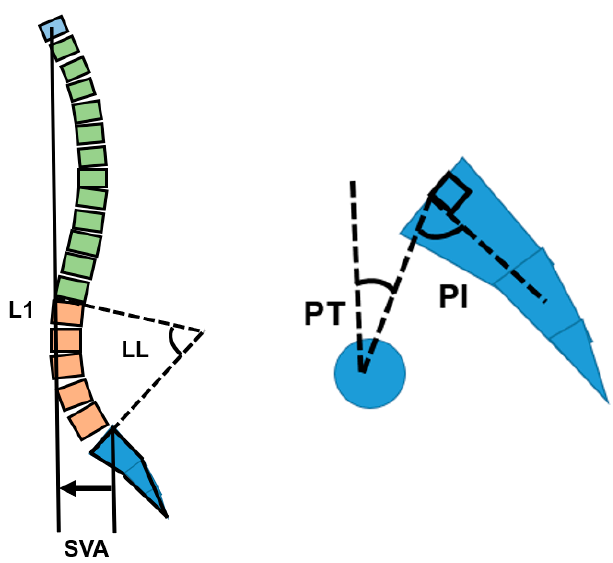
Figure 3. Spinopelvic parameter, SVA; sagittal vertical axis, LL; lumbar lordosis, PT; pelvic tilt, PI; pelvic incidence.